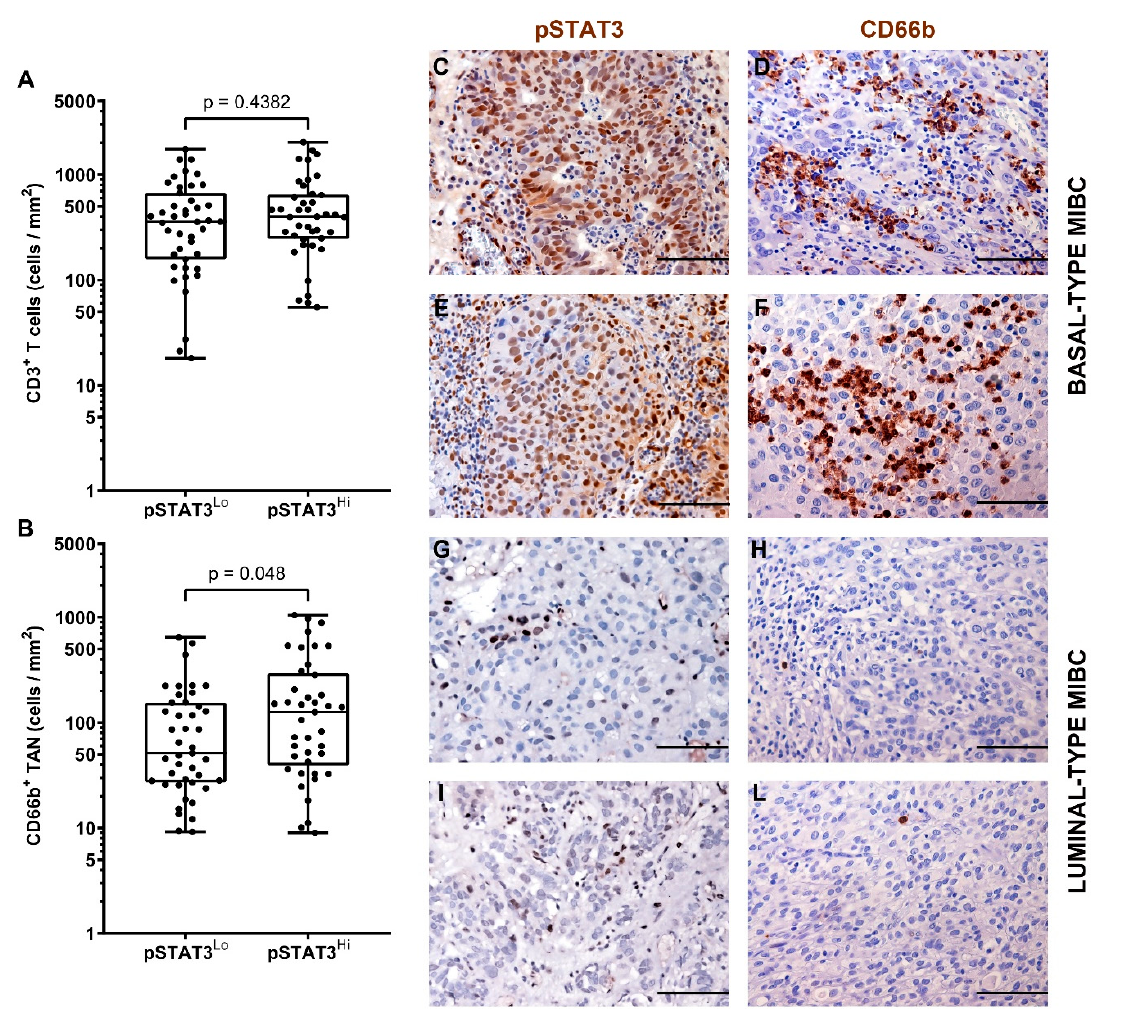
Figure 6. Density of CD66b + TAN and CD3 + T cells in human MIBC with hyper-activation of STAT3. Dot plots indicating the density of CD3 + T cells ( A ) and CD66b + TAN( B ) in the MIBC cohort based on pSTAT3 expression. Sections are from two pSTAT3 HIGH (case 49 and 2, in C – F ) and two pSTAT3 LOW (case 68 and 57, in G – L ) MIBC cases and stained as labeled and counterstained with hematoxylin. Magnification: 200 × ( C – L ), scale bar 100 micron. p values were estimated by Kruskal-Wallis test.